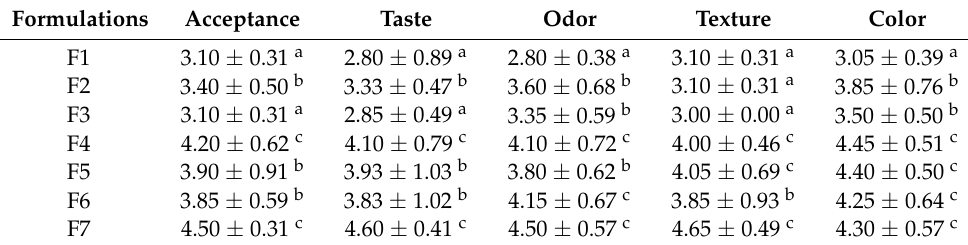
Table 2. Sensory analyses of different soup formulations,